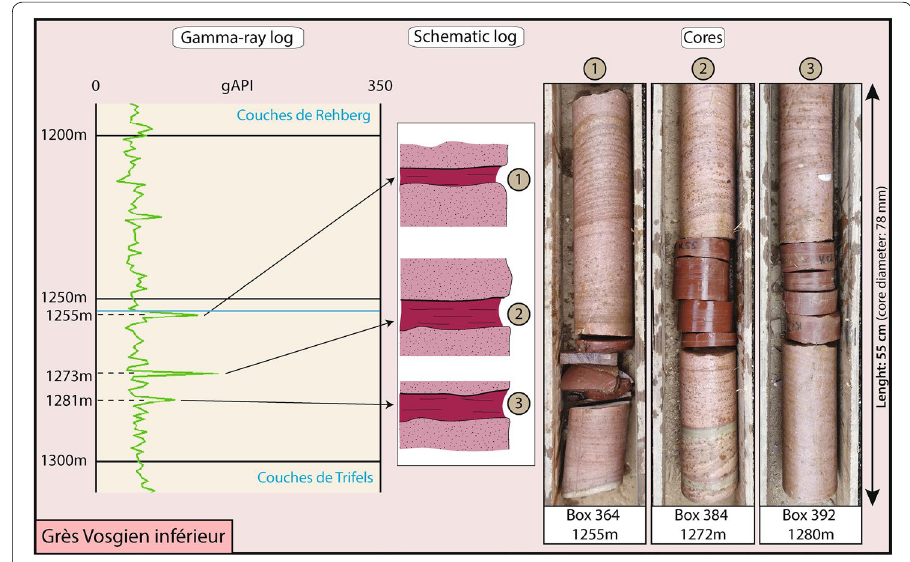
Fig. 8 Focus on the cores from the upper part of the Couches de Trifels (Grès Vosgien inférieur), in conjunction with the gamma-ray log. Boxes 364, 384 and 392, Couches de Trifels: medium-grained sandstones showing white quartz rounded pebbles, mud clasts and three thick silty and micaceous clay beds and cross-bed laminations. The GR peaks located at 1255, 1273 and 1281 m are associated with the schematic log and cores, respectively number 1, 2 and